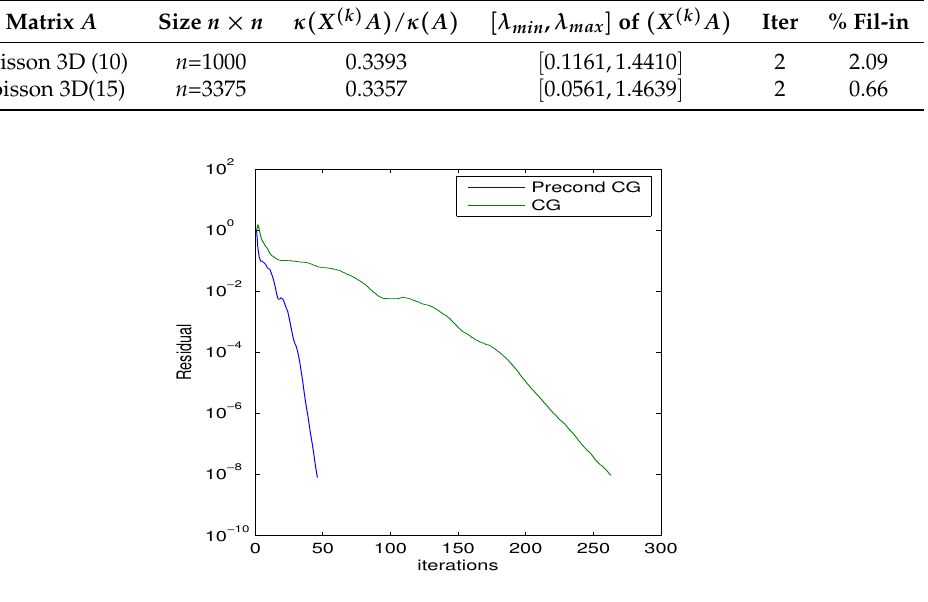
Figure 2. Convergence history of the CG method applied to a linear system with the Wathen matrix, for n = 50, 20 iterations, (cid:101) = 0.01, thr = 0.01, and l fil = 20, using the preconditioned generated by the MinCos Algorithm and without preconditioning.